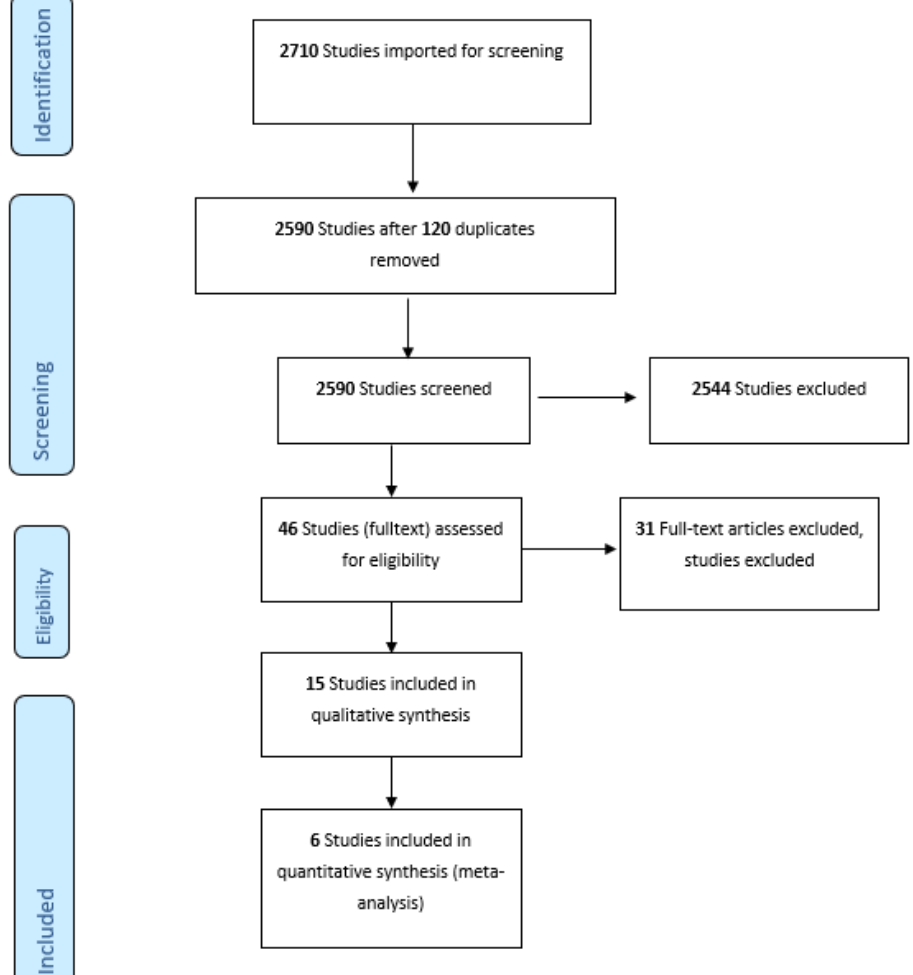
Figure 1. Prisma Flow chart of the screened articles for the systematic review of cut-off values for troponin in patients with chronic kidney disease.